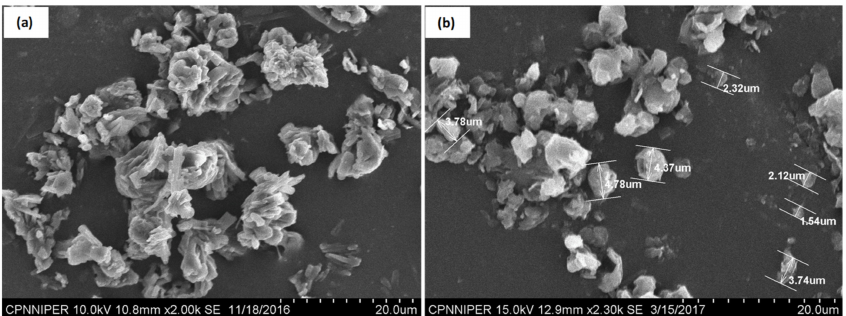
Figure 4. SEM images of primary particles of CEL_NCSD: ( a ) Clumps of needle-shaped CEL_NCSD particles; ( b ) Size measurement of CEL_NCSD